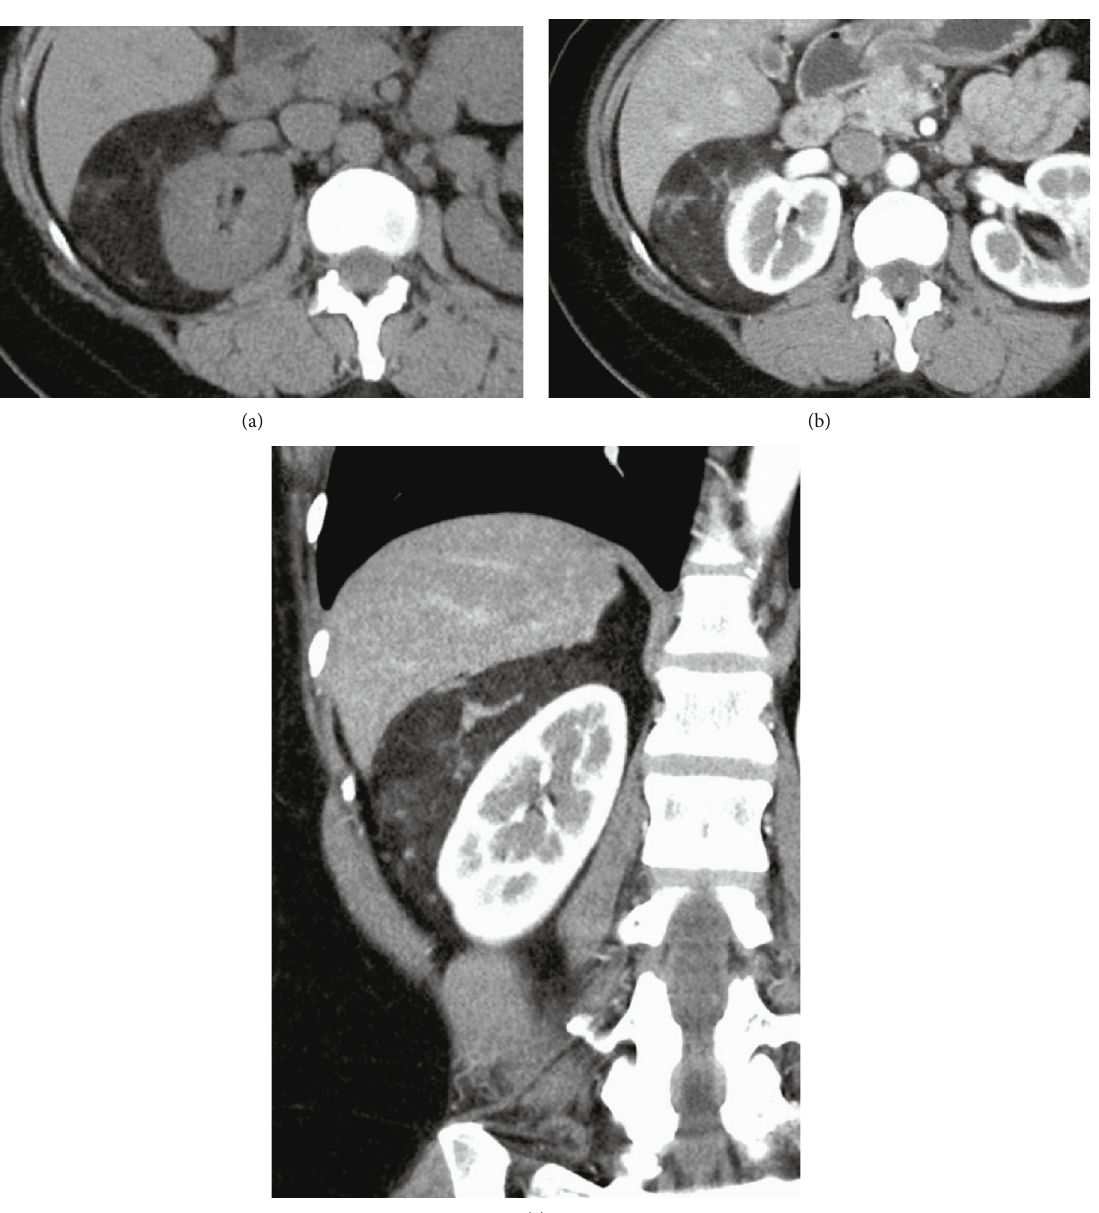
Figure 1: Computed tomography fi ndings. (a) A plain axial section. The tumor was mainly composed of adipose tissue with thick irregular septum-like structures. (b) A contrast-enhanced axial section. The septum-like structures showed early enhancement. (c) A contrast- enhanced coronal section. There was no beak sign or sharp beak shape arising from the